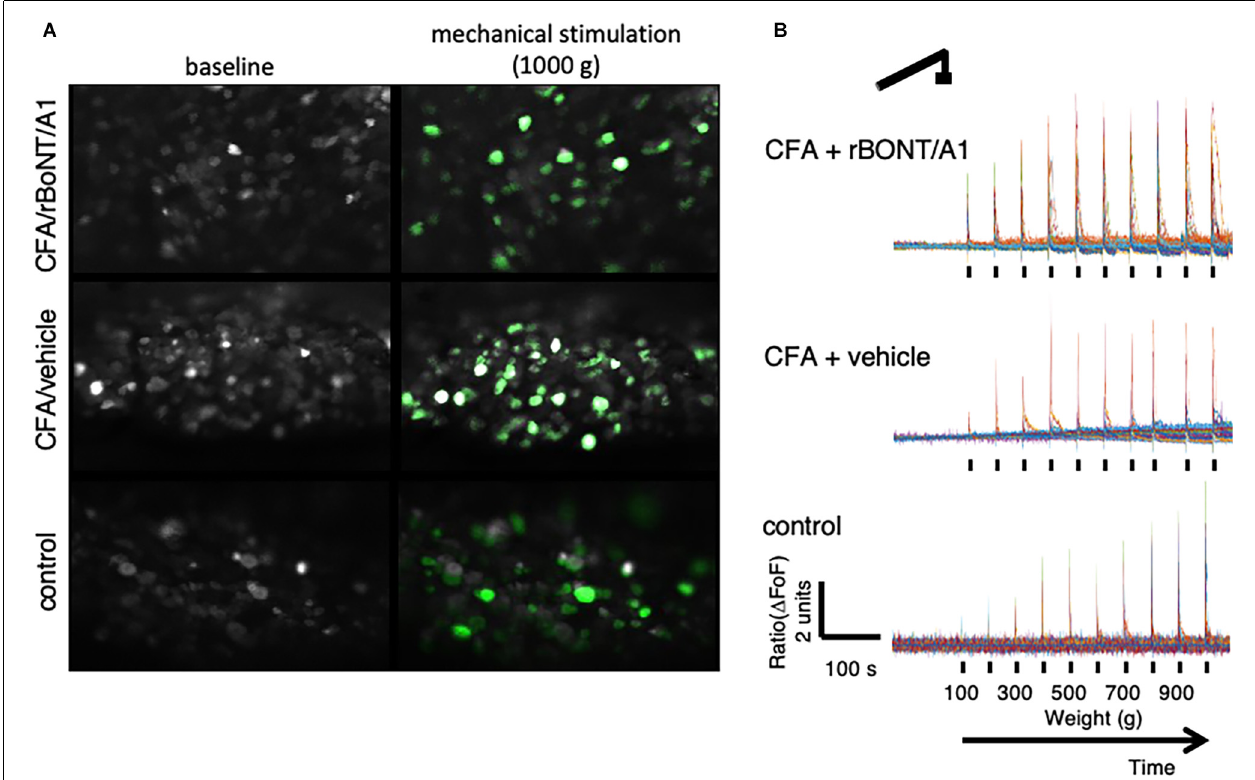
FIGURE 3 | Peripherally applied pressure to hind paws evokes calcium transients in dorsal root ganglion (DRG) neurons in vivo . (A) False color images of GCaMP6s-labeled DRG neurons in situ at baseline and after maximum mechanical stimulation (1,000 g/0.9 N). (B) Traces depict calcium transients normalize to baseline ( ∆ FoF) in individual neurons from mice treated with CFA and rBoNT/A1 (top), CFA and vehicle (GPB; middle), or control (PBS; bottom) upon mechanical stimulation as indicated over time.